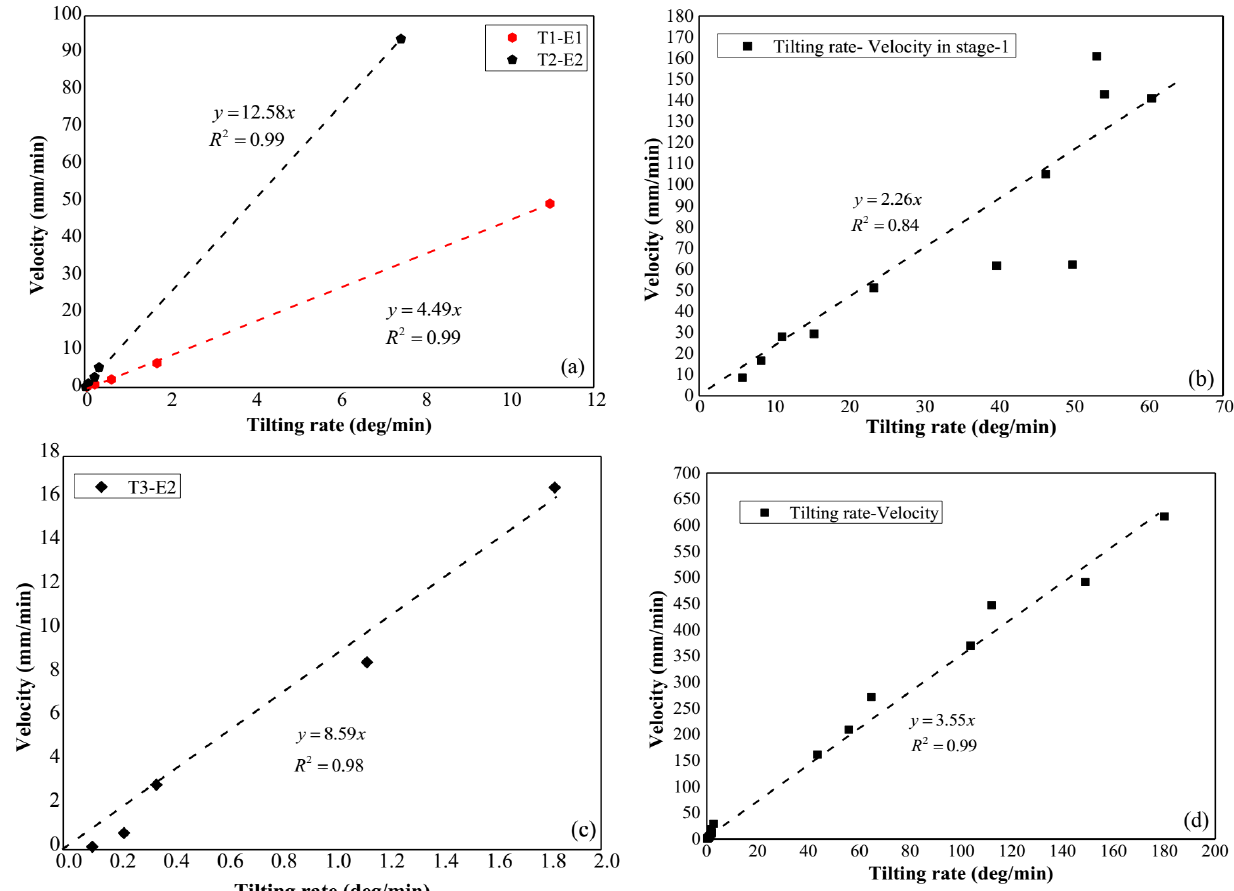
Figure 15. ( a ) Relationship between the tilting rate and the displacement rate in Model Test 1, ( b ) relationship between the tilting rate and the displacement rate in Model Test 2, ( c ) relationship between the tilting rate and the displacement rate in Field Test 1, ( d ) relationship between the tilting rate and the displacement rate in Field Test 2.